Question: In a single sentence, describe what this figure presents.
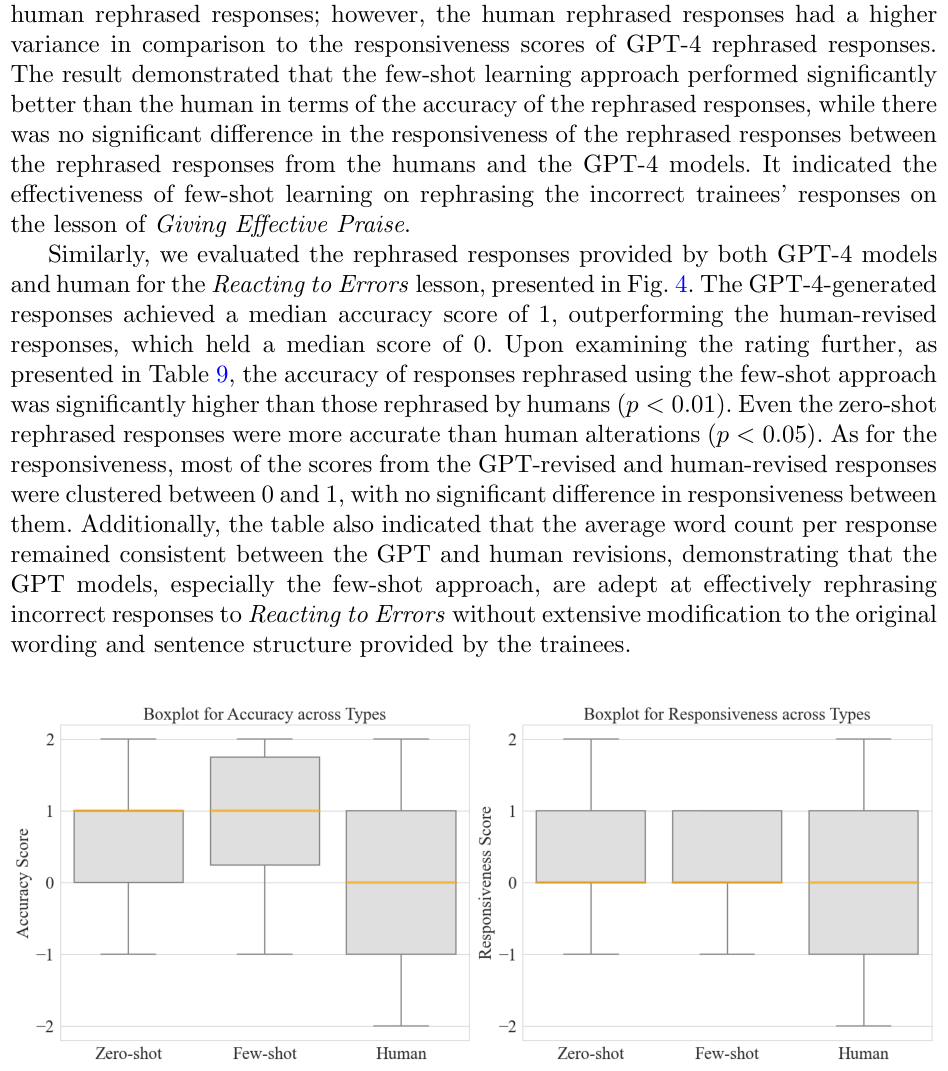
Answer: Distribution of accuracy and responsiveness scores from the lesson Reacting to Errors